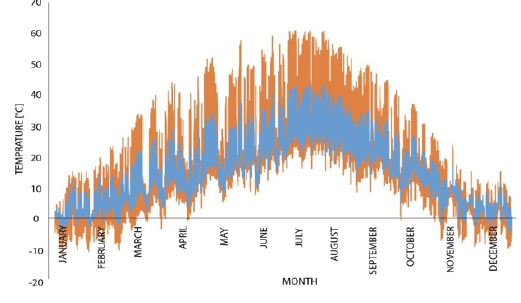
Fig. 2. Roof surface temperature comparison with (blue curve) and without (orange curve) the white coating over a year.